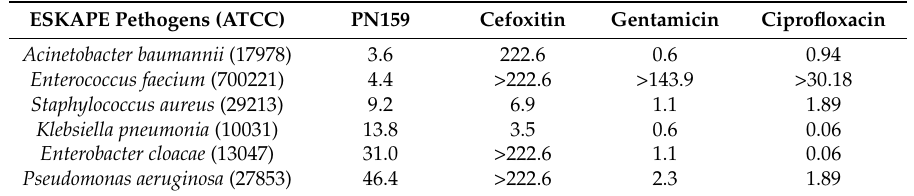
Table 4. Antibacterial activity of PN159 peptide, cefoxitin, gentamicin and ciprofloxacin antibiotics on ESKAPE pathogens. ATCC numbers are added in brackets. MIC ( μ M), minimal inhibitory concentration.